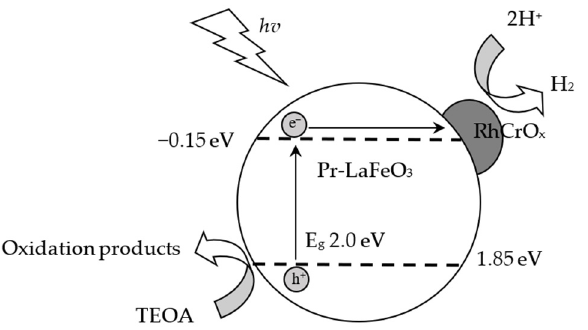
Figure 13. Process of photocatalytic hydrogen evolution over RhCrO x /Pr-LaFeO 3 under visible light irradiation with TEOA as the sacrificial reagent.